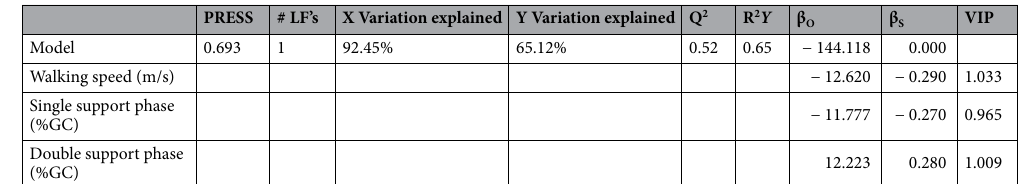
PRESS # LF’s X Variation explained Y Variation explained Q 2